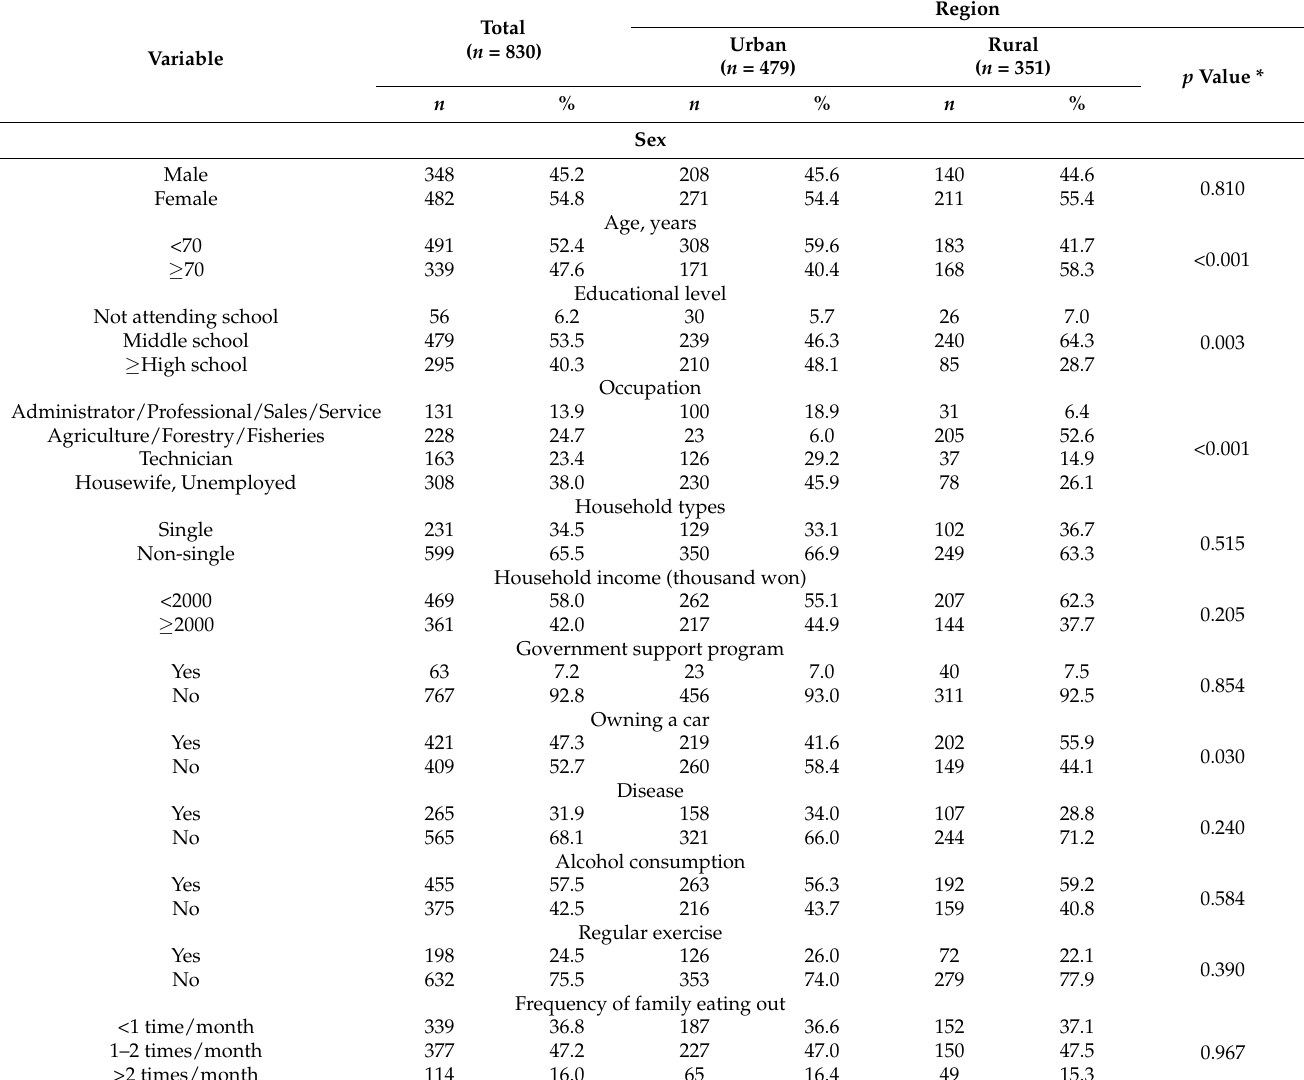
Table 1. General characteristics of study